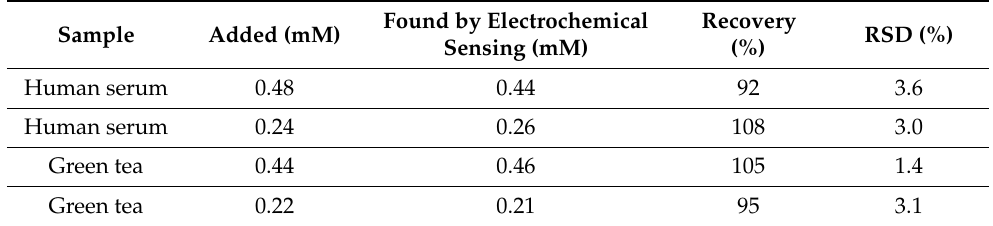
Table 3. The results of the recovery tests and relative standard derivations obtained by the electro- chemical sensing and the mass spectrometric methods.